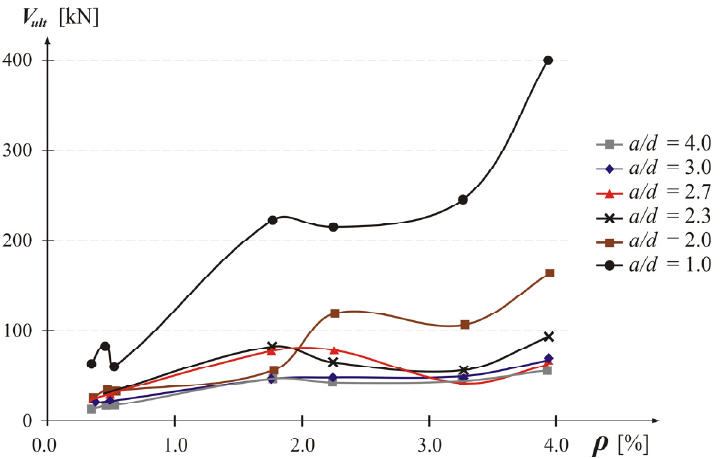
Figure 3. The influence of the longitudinal reinforcement ratio on shear capacity on the basis of test results presented in [22].